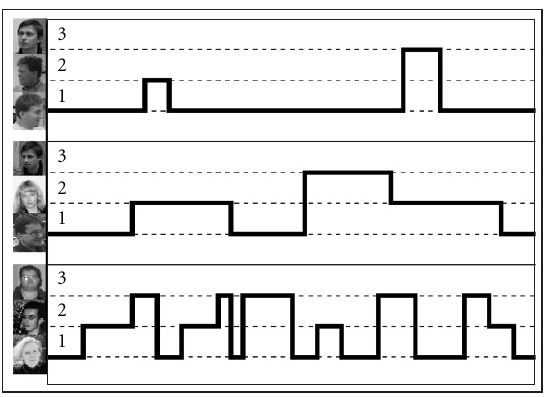
Figure 8: Three samples of turn-taking sequences (speaker versus time). Speaker icons show the identity of each speaker as automati- cally captured by